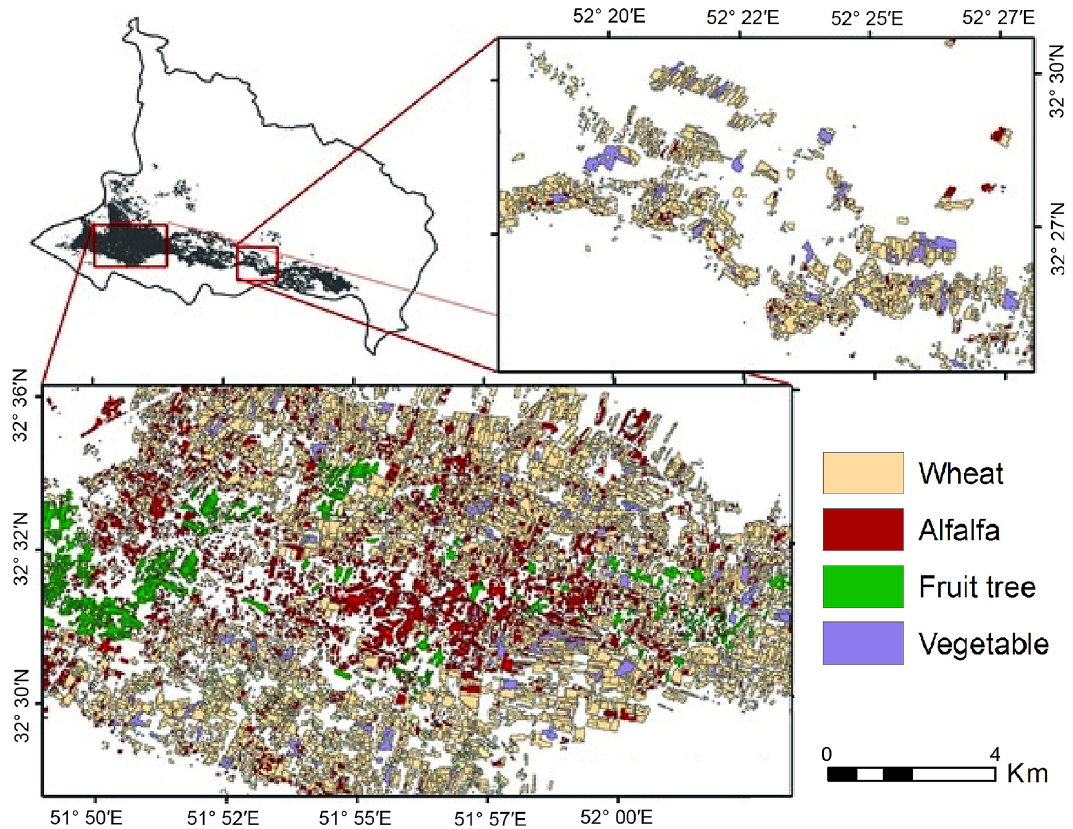
Fig. 2. Crop type map produced from image